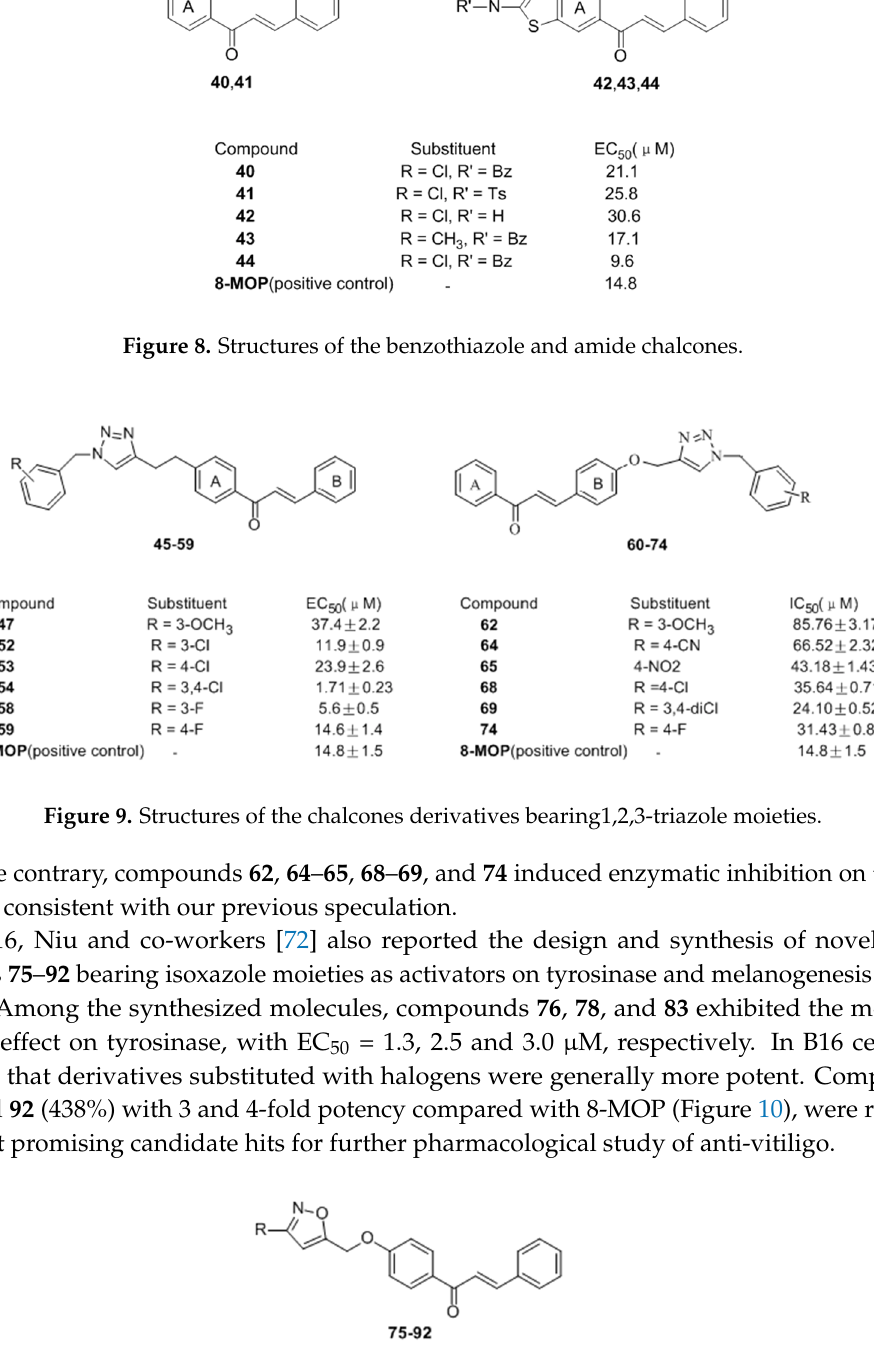
Figure 7. Structures of chalcone derivatives and analogues with activator effect on tyrosinase [68,69].